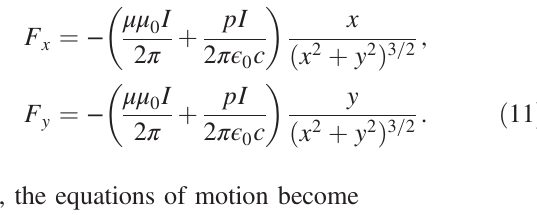
FIG. 1. Magnetic field line pattern around a beam. Magnetic field strength decreases as 1 =r with radial distance r from the origin. The red spot at the center indicates the position of a proton beam leaving the picture plane towards the reader.